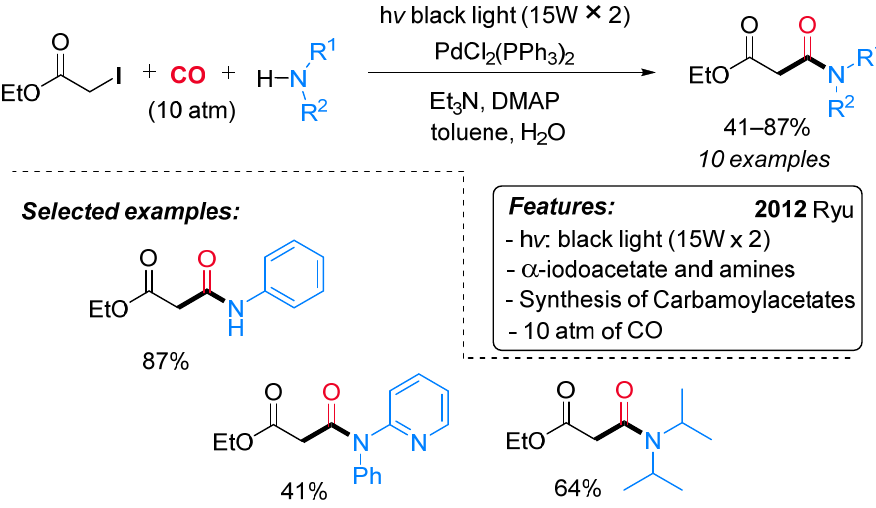
Scheme 8. Palladium-catalyzed/light-induced synthesis of carbamoyl